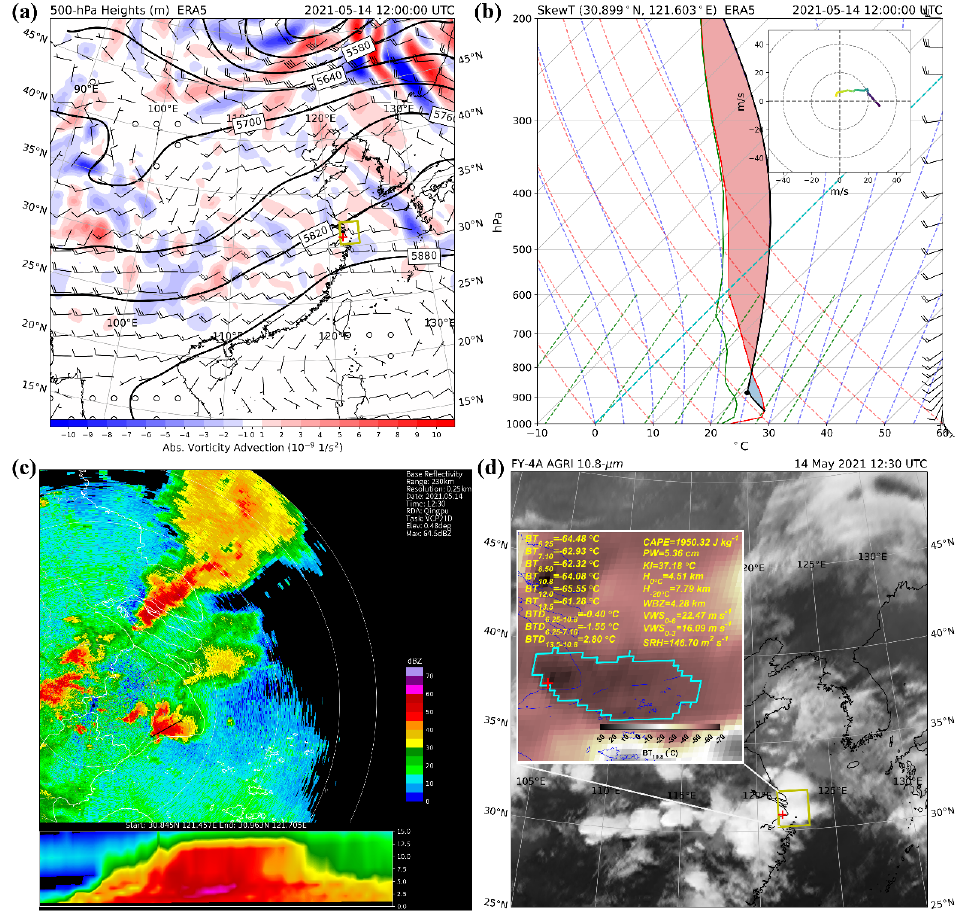
Figure 9. Hail event (red cross) occurred at about 12:30 (UTC) on 14 May 2021, in Fengxian District, Shanghai, China: ( a ) 500 hPa weather map; ( b ) SkewT near hail event; ( c ) radar reflectivity; ( d ) FY-4A 10.8 μ m image, the inset image shows the hailstorm sample (Figure 3a) that was to calculate MHD. The yellow rectangles in ( a , d ) represent the same geographic range.